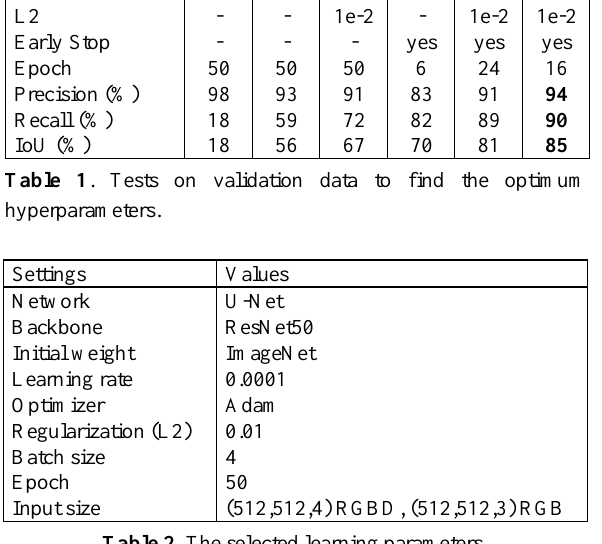
Table 2 . The selected learning parameters.